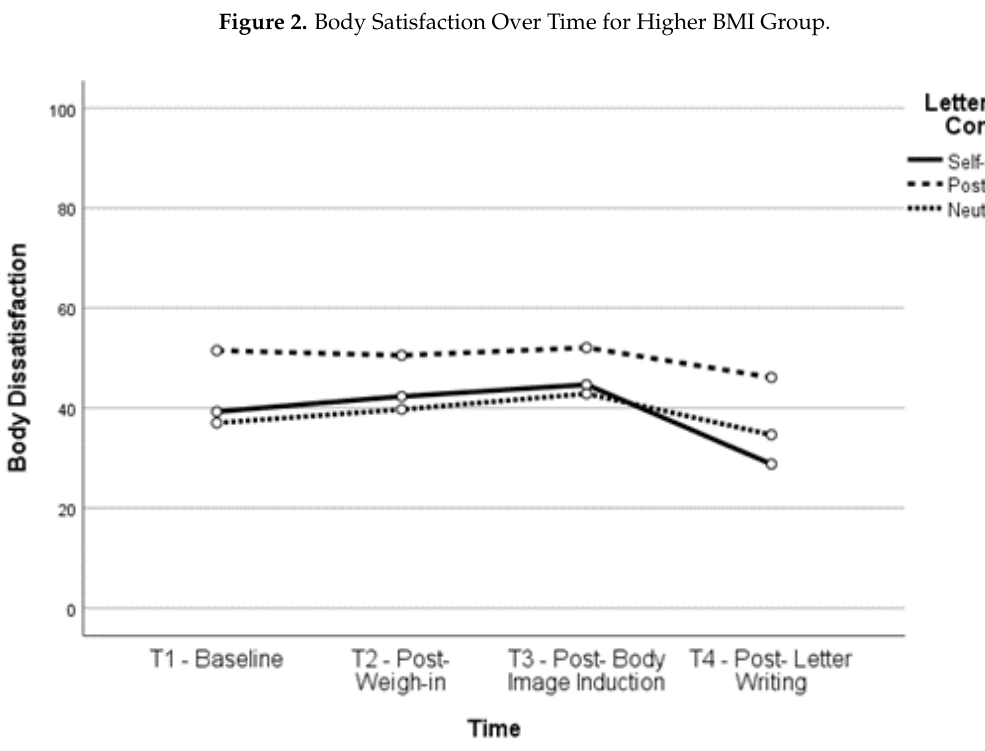
Figure 3. Body Dissatisfaction Over Time for Lower BMI Group.